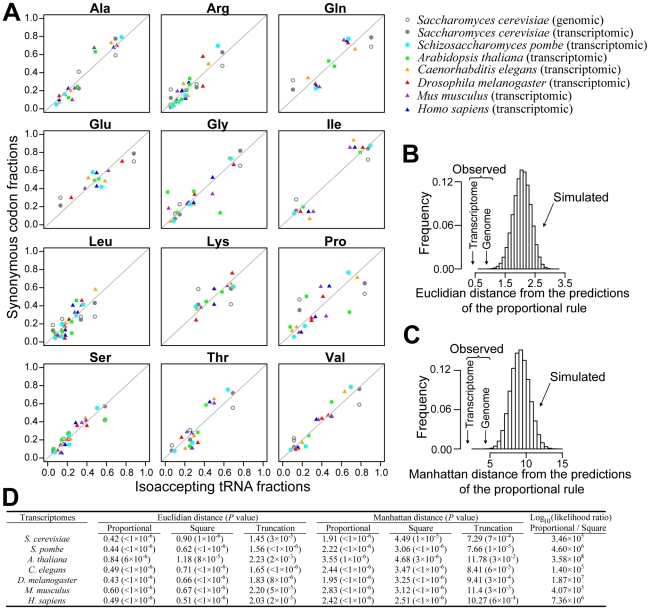
Synonymous codons are used in proportion to cognate tRNA concentrations.(A) Relative uses of synonymous codons in the transcriptomes of seven model eukaryotes are compared to the relative concentrations of cognate tRNAs measured from gene copy numbers, for the 12 amino acids that have at least two isoaccepting tRNA species. For comparison, genomic synonymous codon usage in S. cerevisiae is also presented. The diagonal line shows the predicted proportional relationship between tRNA concentrations and cognate codon uses that maximizes translational efficiency under tRNA shortage. (B) Euclidian and (C) Manhattan distances between the observed synonymous codon usage in S. cerevisiae and the prediction by the proportional rule are significantly smaller than chance expectations. Euclidian and Manhattan distances are defined by  and , respectively, where pi and qi are codon and cognate tRNA fractions, respectively, and k is the number of different tRNA species for the amino acid concerned. The chance expectations are shown by the frequency distributions of the distances under uniformly random codon usage, determined from 106 simulations. (D) Euclidian and Manhattan distances between the observed synonymous codon usage and the predictions under the proportional rule, square rule, and truncation rule, respectively. P values indicate the probability that a distance generated by random codon usage is smaller than the observed distance, determined by 106 simulations. Log10(likelihood ratio) measures the likelihood of the proportional rule, relative to the square rule, given the actual codon usage.